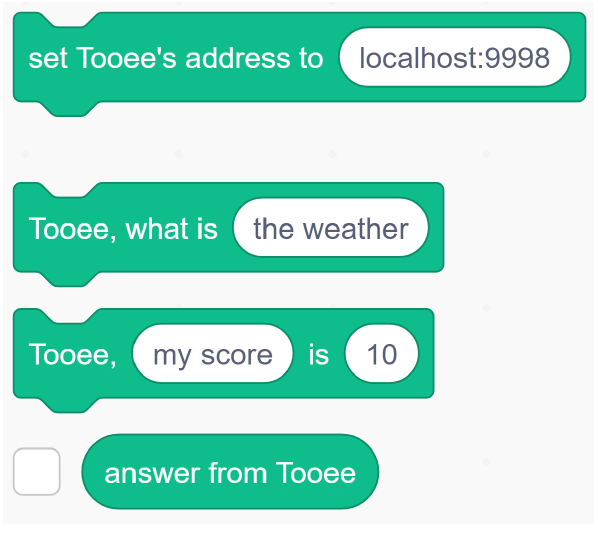
Figure 2. Scratch block interfaces (named Tooee [2]) for communicating with WebSocket servers. Our programming blocks were built on top of these block